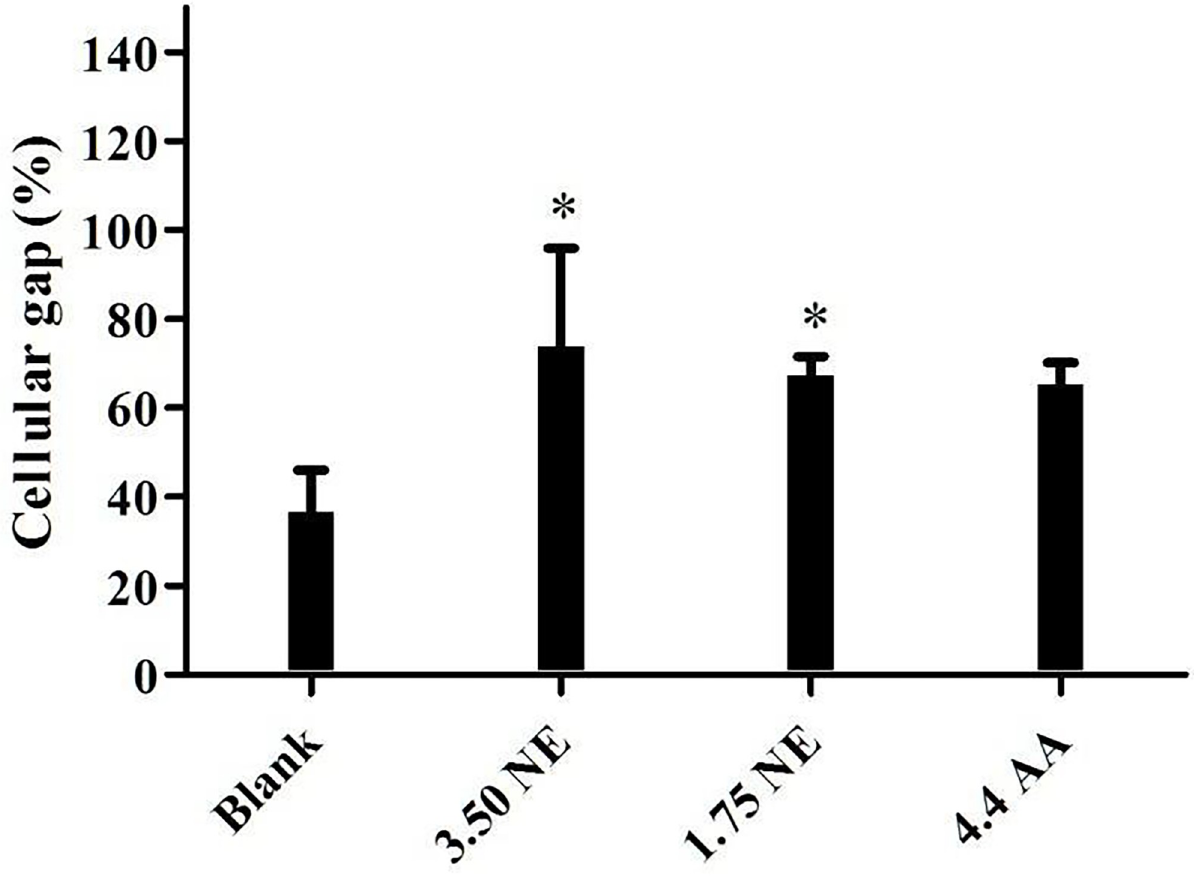
Fig 2. Keratinocytes cellular gap closure after different treatments. Notes: Blank = untreated samples; AA = Ascorbic acid; NE = Nanoemulsions; All concentration is in μ g/mL. ( � ) Means significant differences found when compared to the lank.